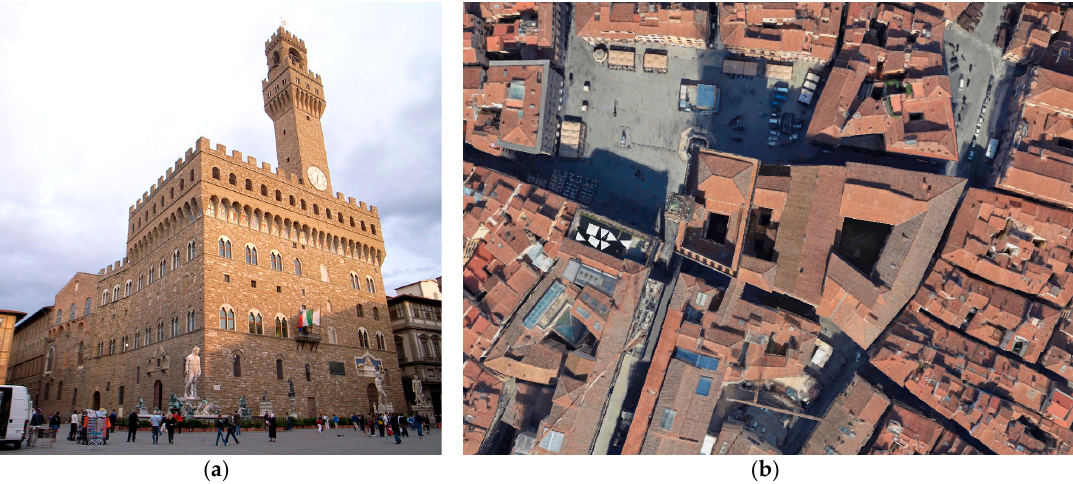
Figure 4. ( a ) The main façade of the Palazzo Vecchio in Piazza della Signoria; ( b ) the structural aggregate of Palazzo Vecchio.